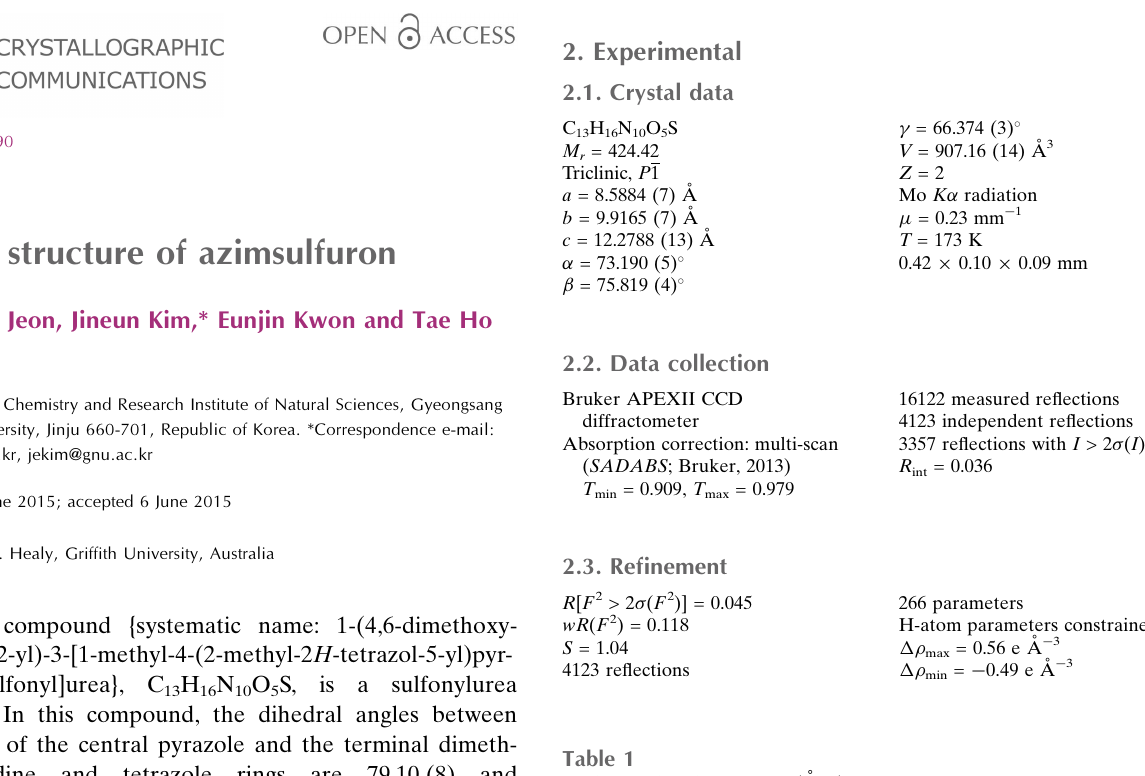
Hydrogen-bond geometry (A˚ , (cid:2)